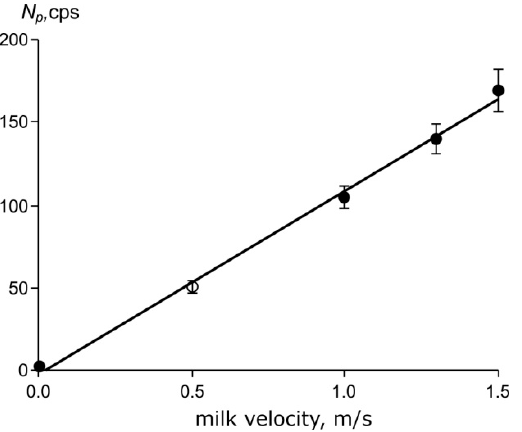
Figure 11. Influence of the milk velocity on the counting rate of response pulses 𝑁 𝑝 , measured as the number of counts per second (cps) in the reference signal.